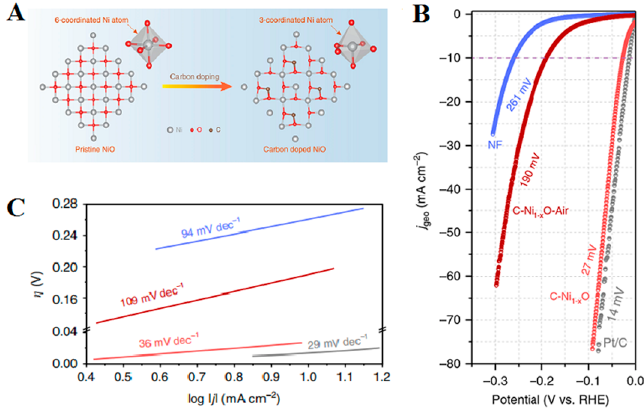
Figure 9. ( A ) Density functional theory (DFT) calculations for the structure changes of NiO with carbon doping. ( B ) Polarization curves of NF, C–Ni 1-x O–Air (annealed in air), C–Ni 1-x O, and Pt/C in carbon doping. ( B ) Polarization curves of NF, C–Ni 1 − x O–Air (annealed in air), C–Ni 1 − x O, and Pt / C in N 2 -saturated 1.0 M KOH. ( C ) Tafel slopes of NF, C–Ni 1-x O–Air, C–Ni 1-x O, and Pt/C (reprinted with N 2 -saturated 1.0 M KOH. ( C ) Tafel slopes of NF, C–Ni 1 − x O–Air, C–Ni 1 − x O, and Pt / C (reprinted with permission from ref [53]. Copyright © 2020, Springer). permission from ref [53]. Copyright © 2020,